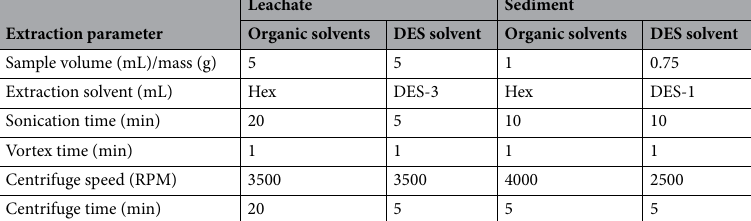
Table 2. Optimum OPFR extraction conditions obtained for the leachate and sediment using hexane and green DES solvents. Hex = hexane; DES-3 = choline chloride/oxalic acid dihydrate (1:1) and DES-1 = choline chloride/urea